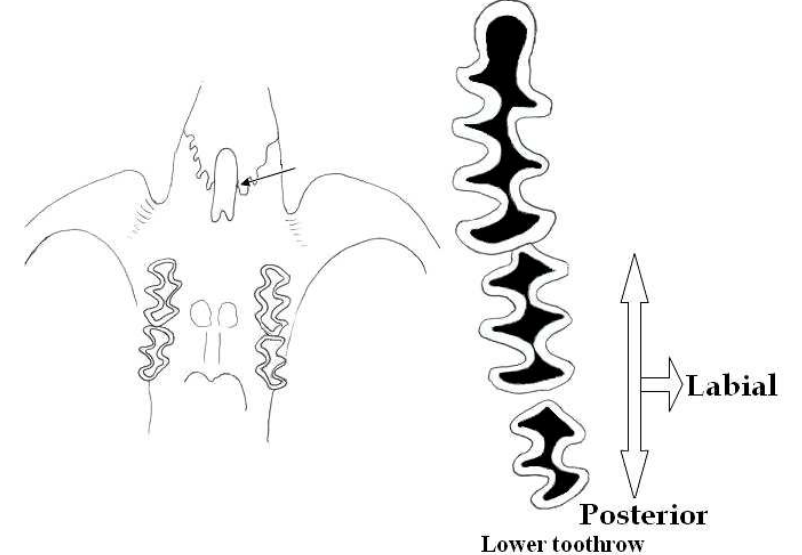
FIGURE 5 : Ventral view the skull and lower tooth row in E. talpinus